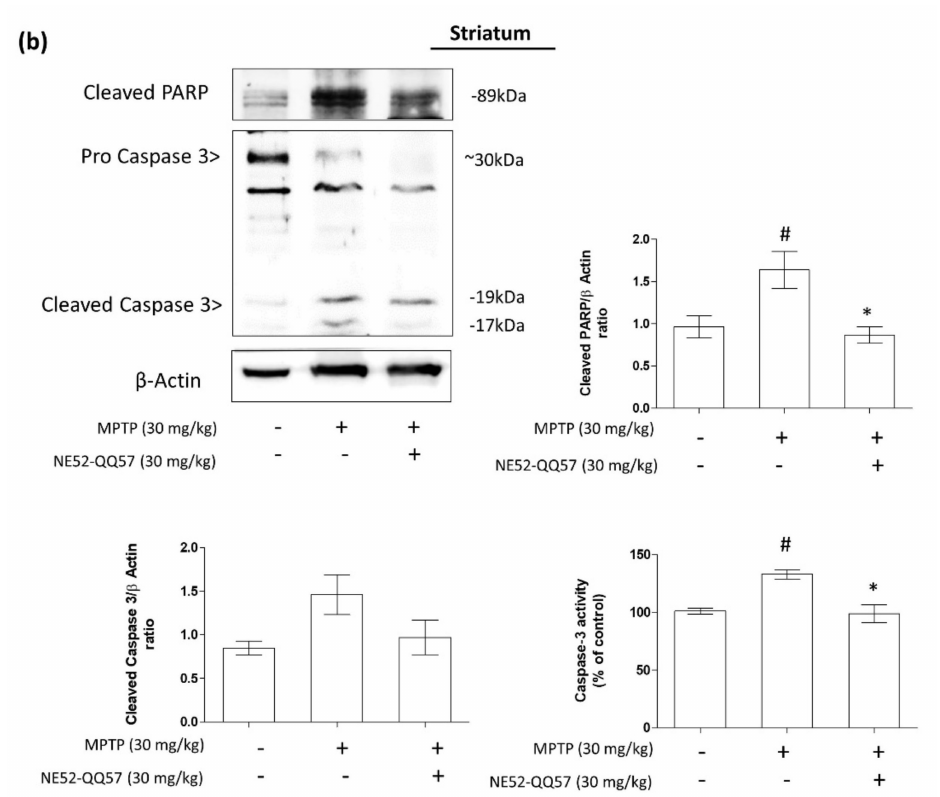
Figure 4. The effects of the GPR4 antagonist NE52-QQ57 on the expression of pro-apoptotic proteins, cleaved PARP and cleaved caspase 3, and caspase 3 activity in MPTP-treated mice. MPTP was administered (30 mg/kg/day) for 5 days. Mice were sacrificed, and the substantia nigra and striatum tissue was collected 3 days after the final MPTP administration. ( a ) Cleaved PARP-1 and cleaved caspase 3 protein expression and caspase 3 activity assay in the mouse SNpc ( n = 3) and densitometric analysis. ( b ) Cleaved PARP-1 and cleaved caspase 3 protein expression and caspase 3 activity assay in the mouse striatum ( n = 3) and densitometric analysis. β -Actin was utilized as an internal control. Data are presented as the mean ± SEM. One-way ANOVA, followed by Tukey’s multiple comparison test, was used to compare differences between groups. # p < 0.05 when the MPTP-treated group was compared with the vehicle-only group; * p < 0.05 when the other treated groups were compared with the MPTP-treated